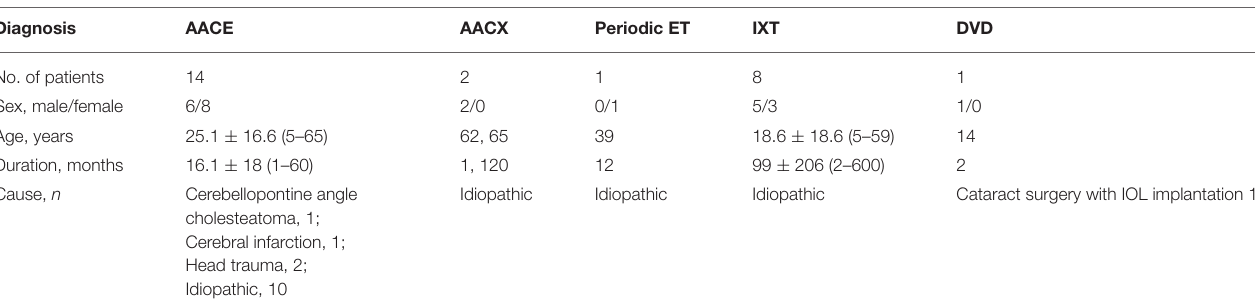
TABLE 5 | Characteristics of comitant strabismus